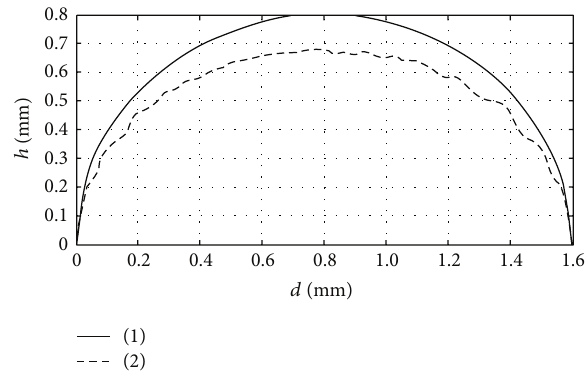
Figure 4: The comparison chart between actual intermediate sectional area and ideal intermediate sectional area: (1) ideal pit morphology and (2) actual pit